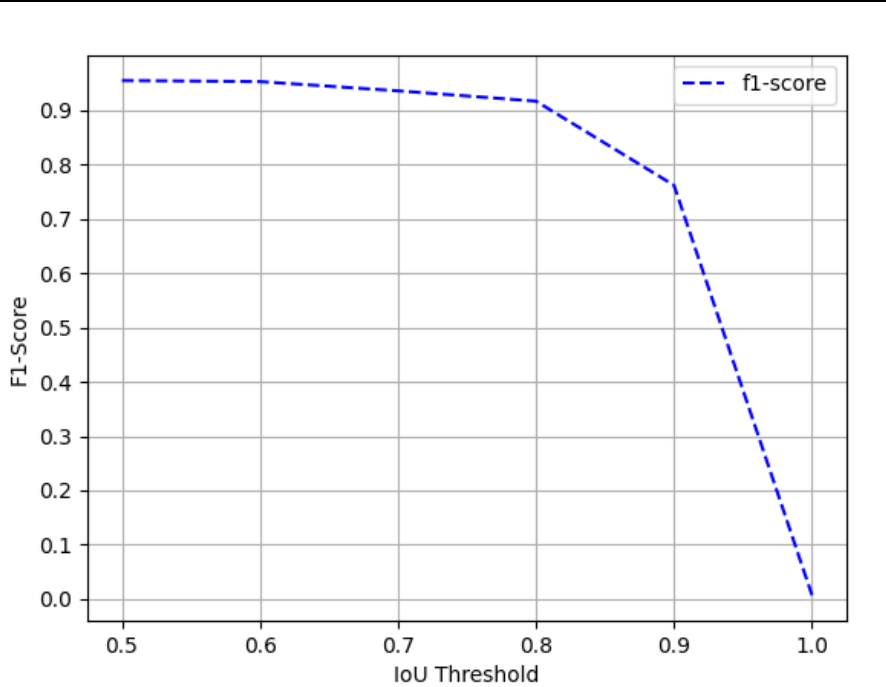
Figure 7. Performance evaluation in terms of f1-score over the varying IoU thresholds ranging from 0.5 to 1.0 on the ICDAR-2017-POD